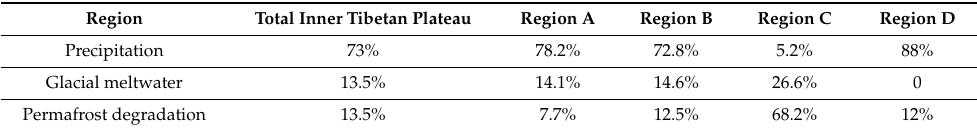
Table 3. Contributions of different factors to lake expansion in different regions. Region Total Inner Tibetan Plateau Region A Region B Region C Region D Precipitation 73% 78.2% 72.8% 5.2% 13.5%